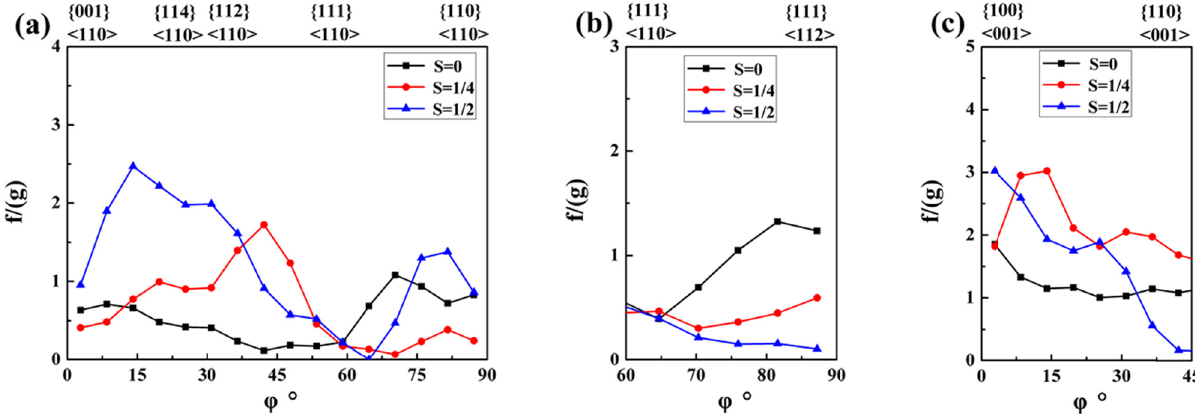
Figure 15: Distribution of orientation lines on di ff erent thicknesses of hot - rolled sheet containing Y: ( a ) α orientation line; ( b ) γ orientation line; and ( c ) η orientation